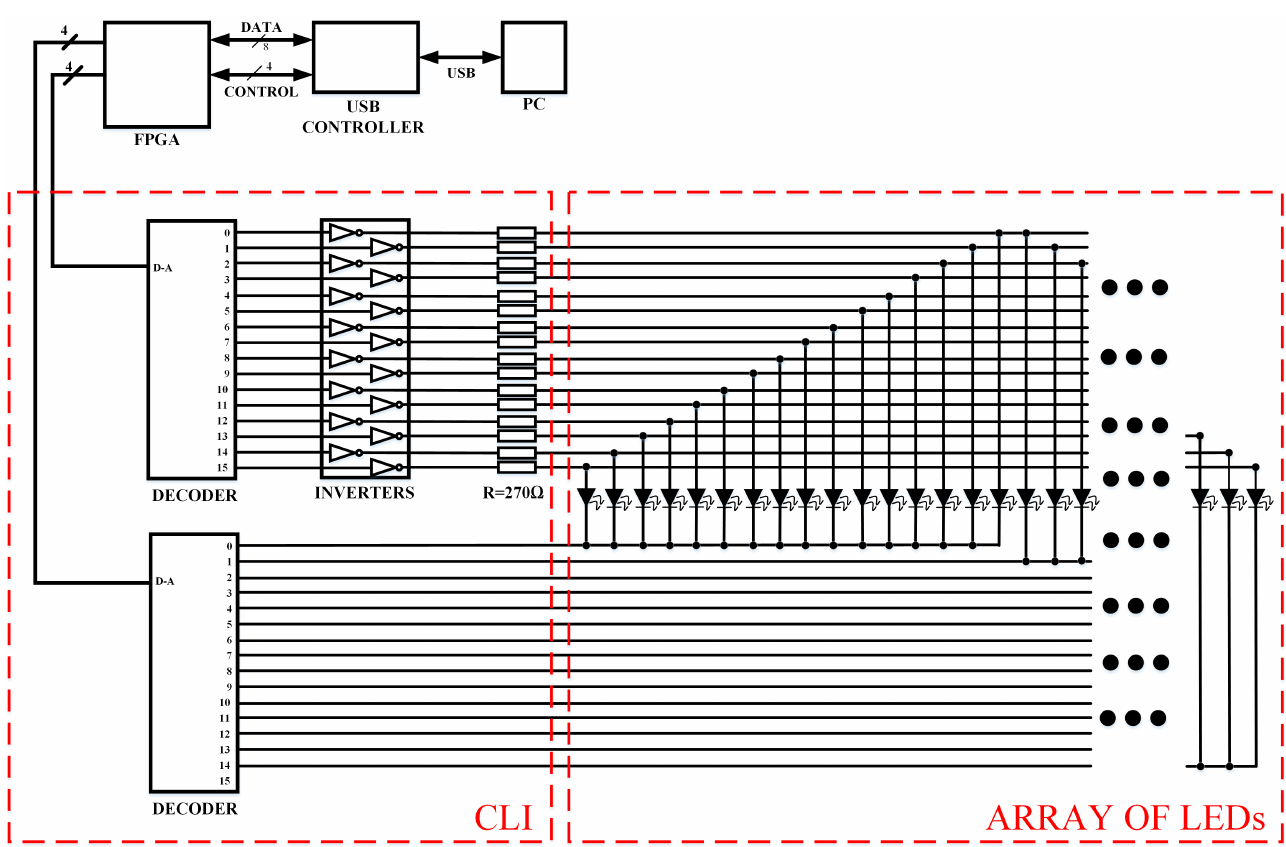
Figure 7. Details of the Combinational Logic Interface (CLI) to address the LEDs in the Stimulus